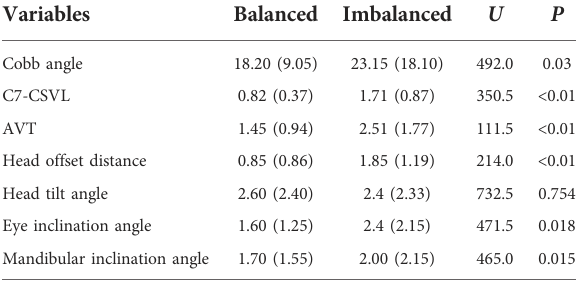
( Table 6 ), and the pressure load ratio of anterior and posterior foot pressure was studied based on the trunk balance and imbalance on the sagittal plane ( Table 7 ). A signi fi cant moderately positive correlation ( r = 0.630, P = 0.000) was found in the percentage difference of left and right foot pressure load and the offset distance of X-axis center of gravity, whereas a signi fi cant low positive correlation ( r = 0.332, P = 0.045) was also found in the percentage difference of front and rear foot pressure load and the offset distance of Y-axis center of gravity.